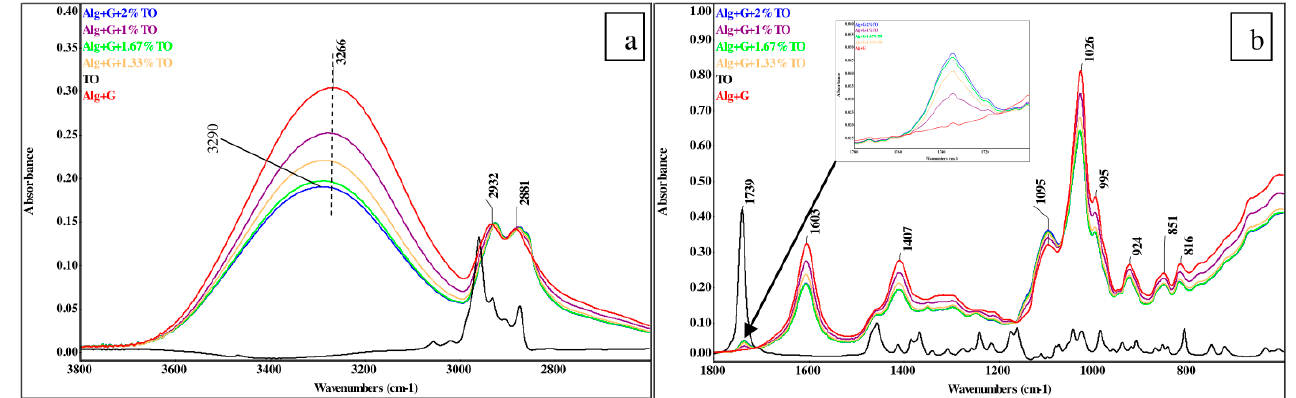
Figure 1. ATR-FTIR spectra of the plasticized alginate film (Alg + G), alginate films with tansy essential oil (Alg + G + TO), and tansy essential oil (TO). ( a ) the spectra in the range of 2600 − 3800 cm − 1 , ( b ) the same spectra in the range of 600 − 1800 cm − 1 .